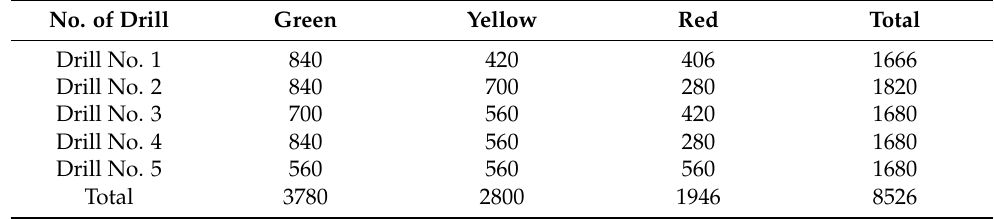
Table 1. Structure of used data set, including number of images for each class for the sequentially used drills.